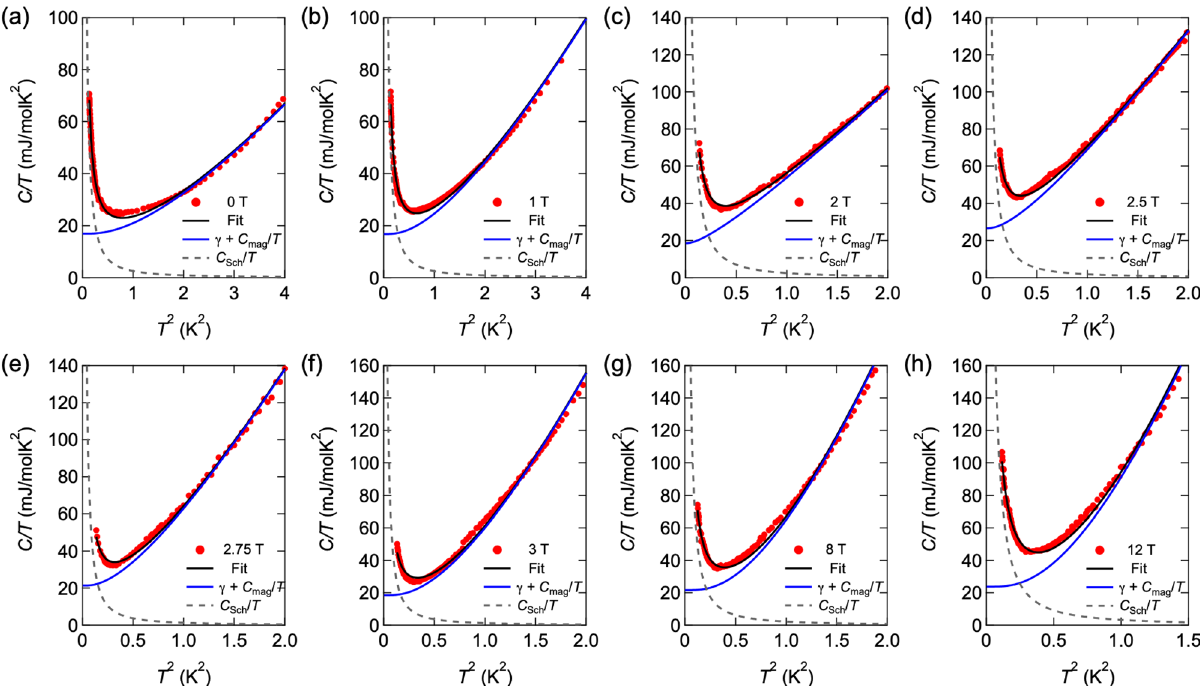
Fig. 6 Fits to the speci fi c-heat data. a – h C / T vs. T 2 for crystal #1 at several fi elds at low temperatures. The black solid, gray dashed and blue solid lines represent the total C / T , Schottky contribution, and γ + β M T α term, respectively, which are obtained by the fi tting using Eq. (1).